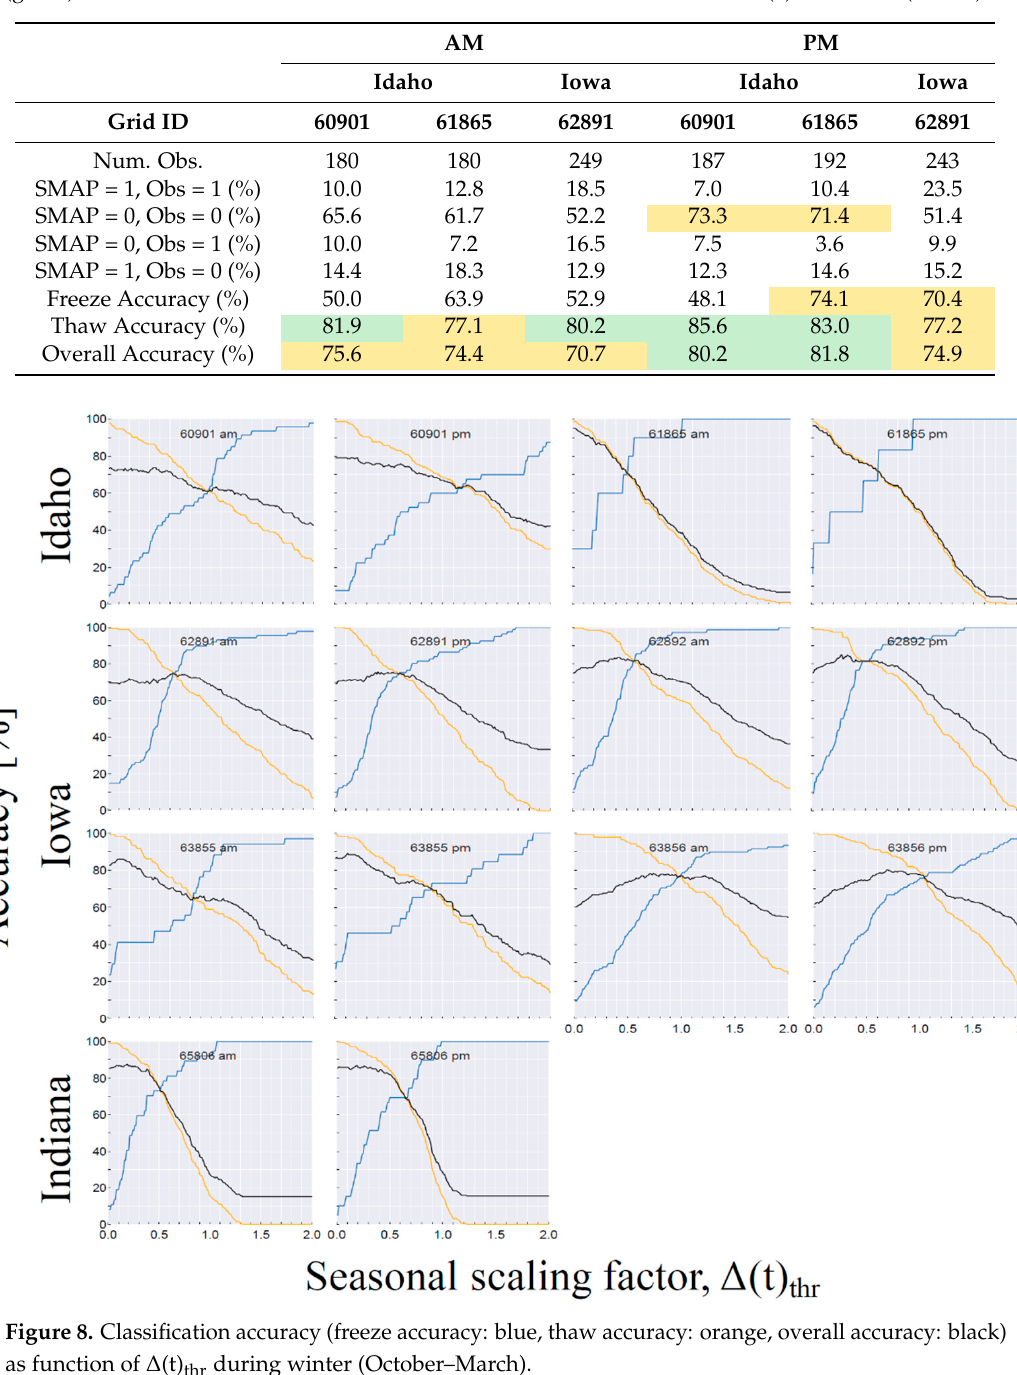
Table 5. Same as Table 4, except that the mean temperatures of CVS stations are used, and comparisons are made with respect to the SMAP grid corresponding to the CVS centroid location. Because the Idaho centroid was located in-between Idaho grids 60901 and 61865, the site mean temperature is compared to SMAP FT retrievals at both grids. Values equal to and above 70% (80%) are highlighted in yellow (green). ‘SMAP’ and ‘Obs’ are the SMAP and in situ freeze-thaw state with 0 (1) as thawed (frozen).